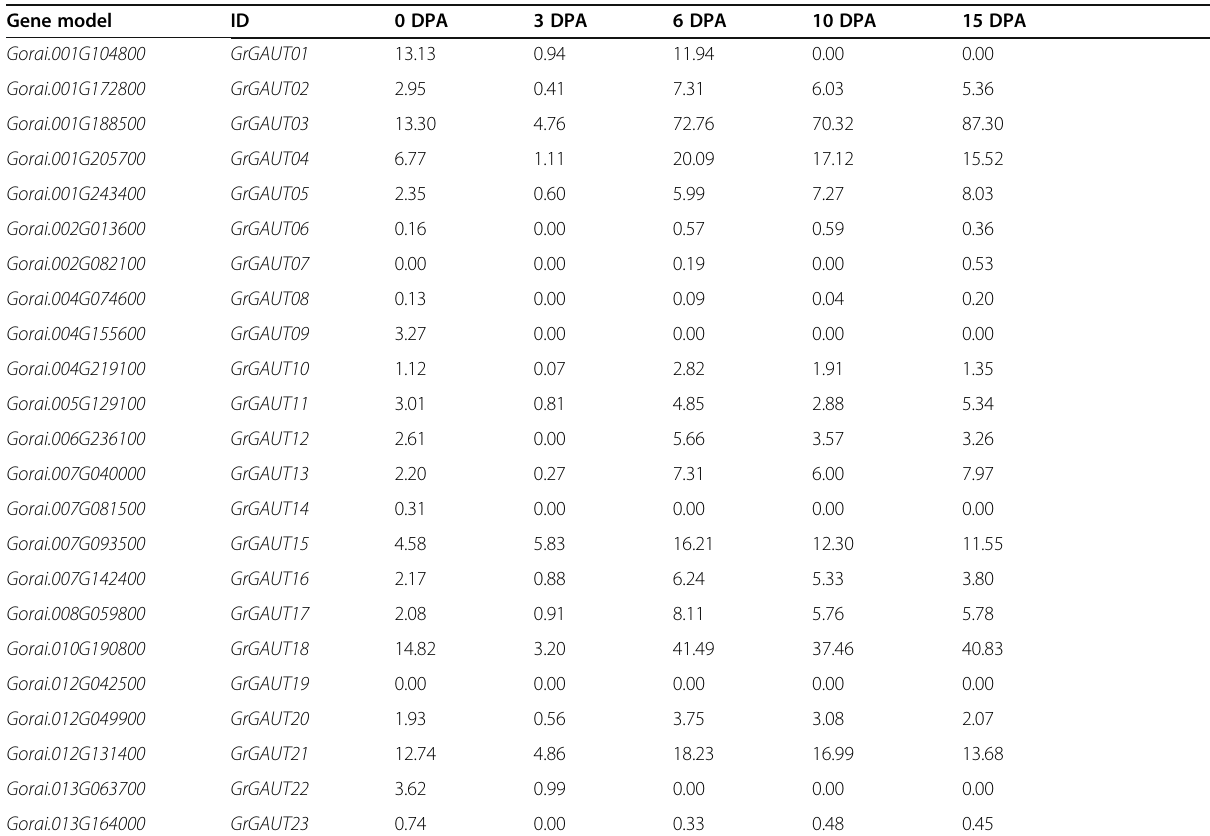
Table 3 The FPKM value of GAUT genes in G. raimondii Gene model